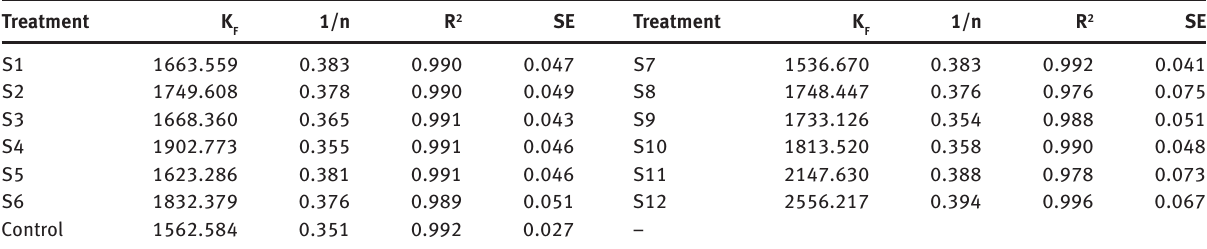
Table 6: Coefficients of the Freundlich sorption isotherm, R 2 , and SE for the Cd sorptions of different treatments.